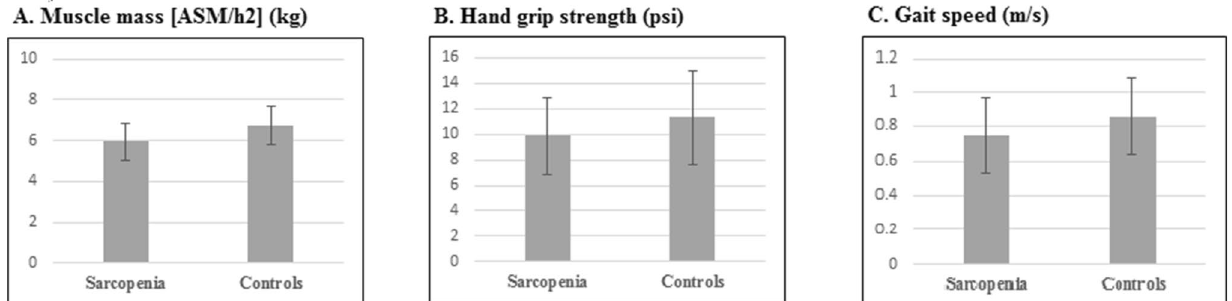
Figure 1. Mean muscle mass, hand grip strength and gait speed between cases and controls. A. Comparison of cases and controls in mean muscle mass, B. Comparison of cases and controls in hand grip strength. C. Comparison of cases and controls in gait